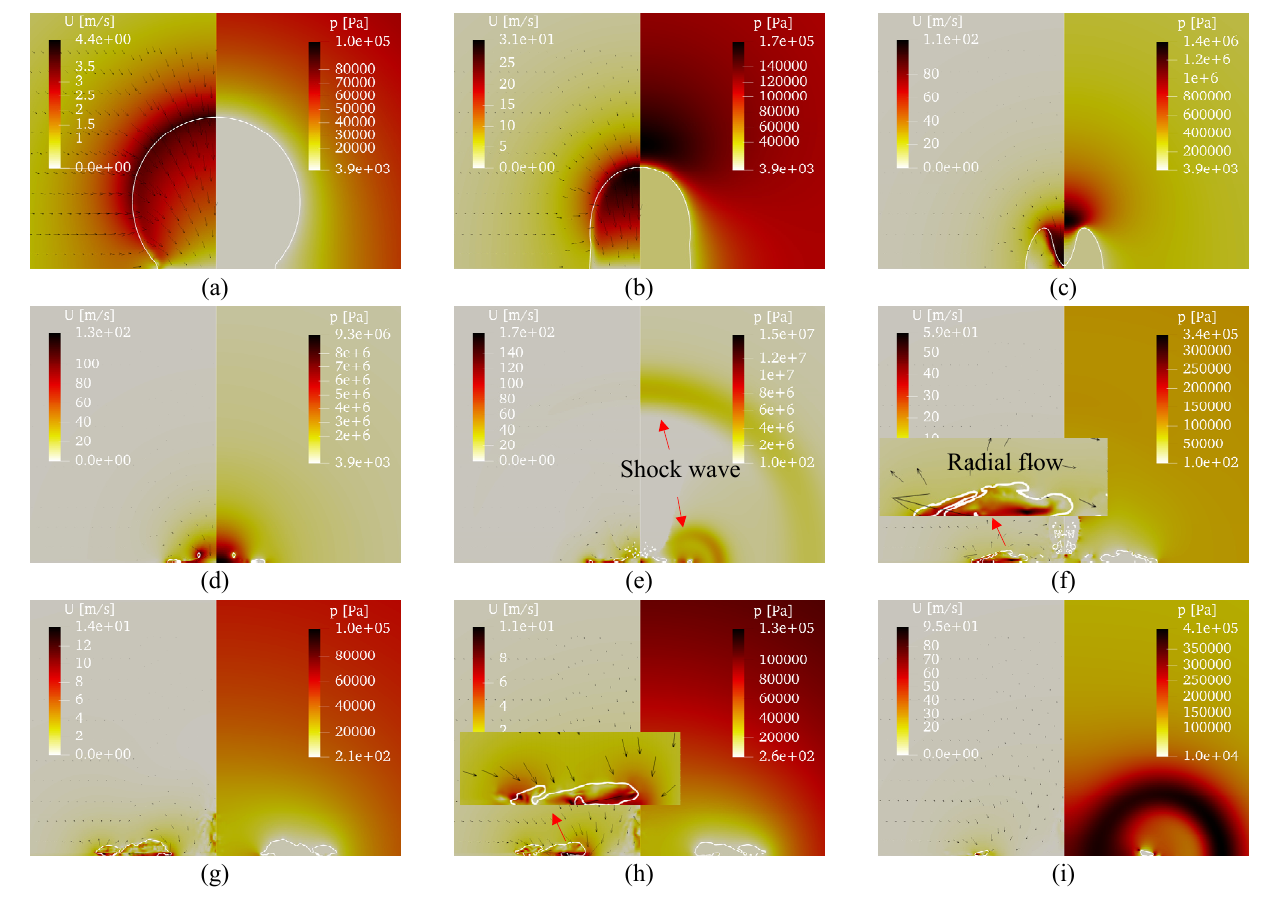
Figure 4. Velocity (left-hand side) and pressure (right-hand side) fields in the process of multi-period cavitation collapse when γ = 0.8. ( a ) 𝑡 ∗ = 0.430, ( b ) 𝑡 ∗ = 1.004, ( c ) 𝑡 ∗ = 1.162, ( d ) 𝑡 ∗ = 1.234, ( e ) 𝑡 ∗ = 1.248, ( f ) 𝑡 ∗ = 1.391, ( g ) 𝑡 ∗ = 1.721, ( h ) 𝑡 ∗ = 2.008, and ( i ) 𝑡 ∗ = 2.295.